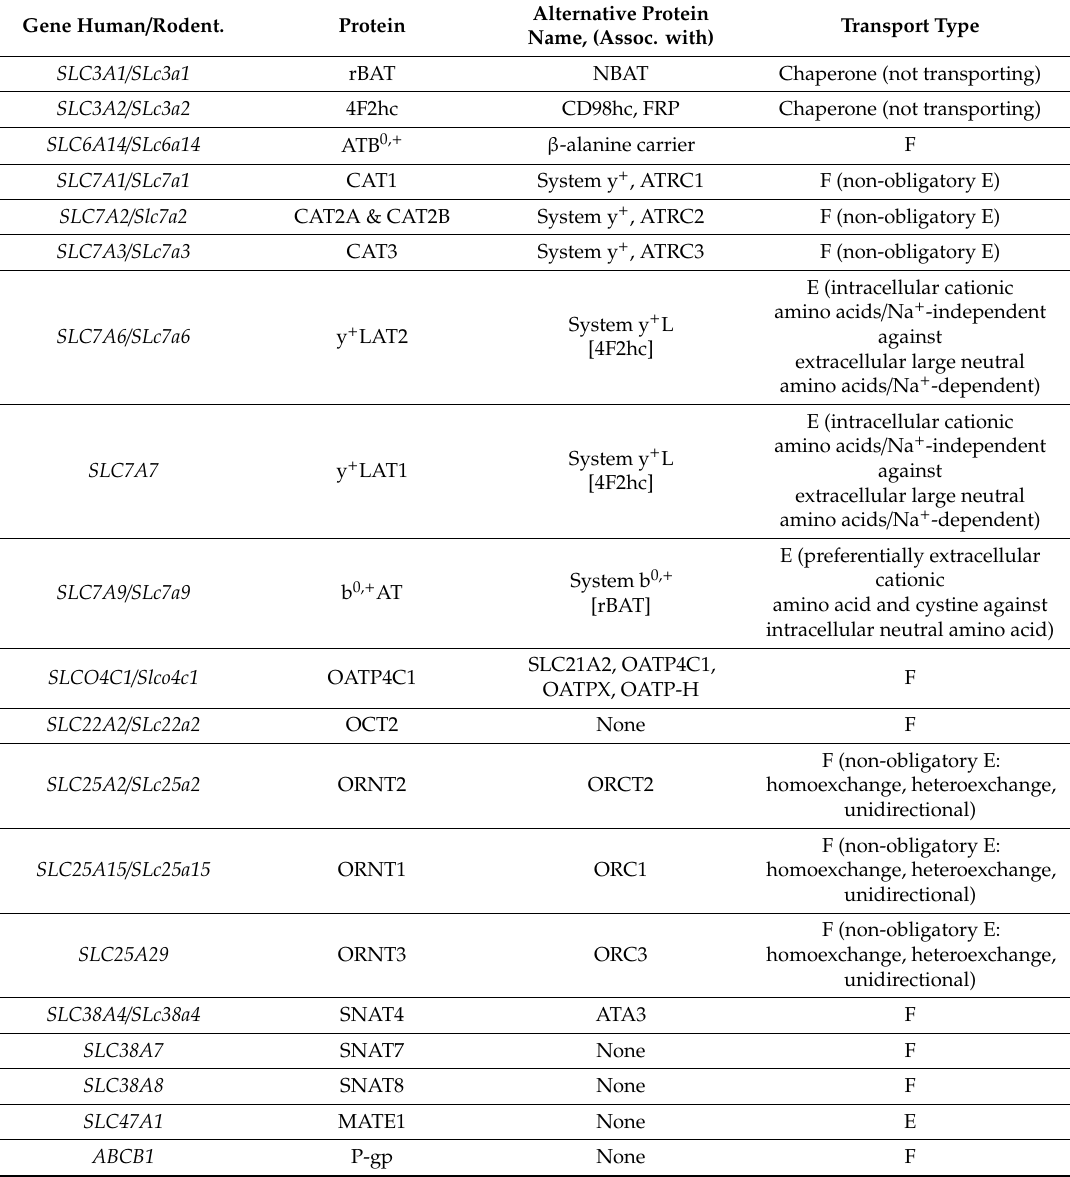
Table 2. Nomenclature of transporters of L-arginine and its derivatives. Gene Human /